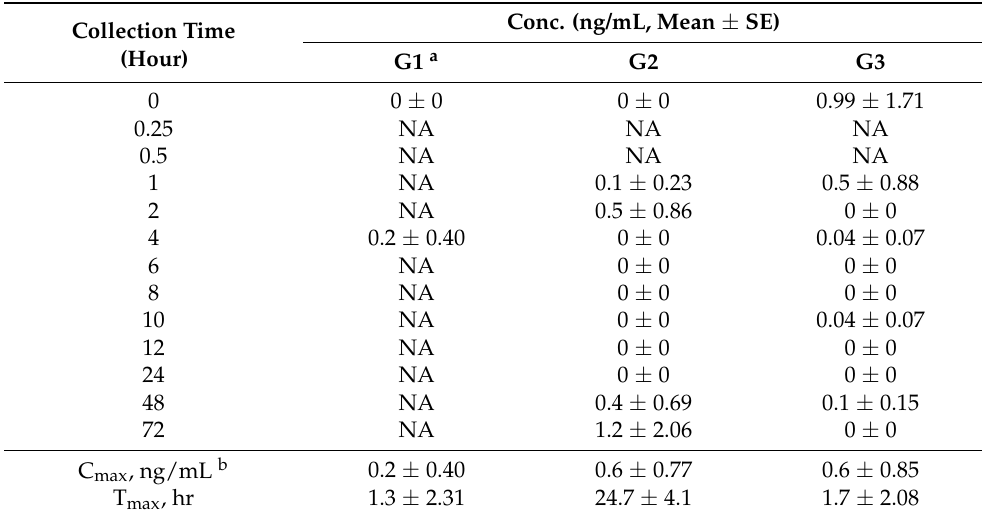
Table 10. Plasma concentration versus time profiles for veratraldehyde after percutaneous application (G1~G3) of